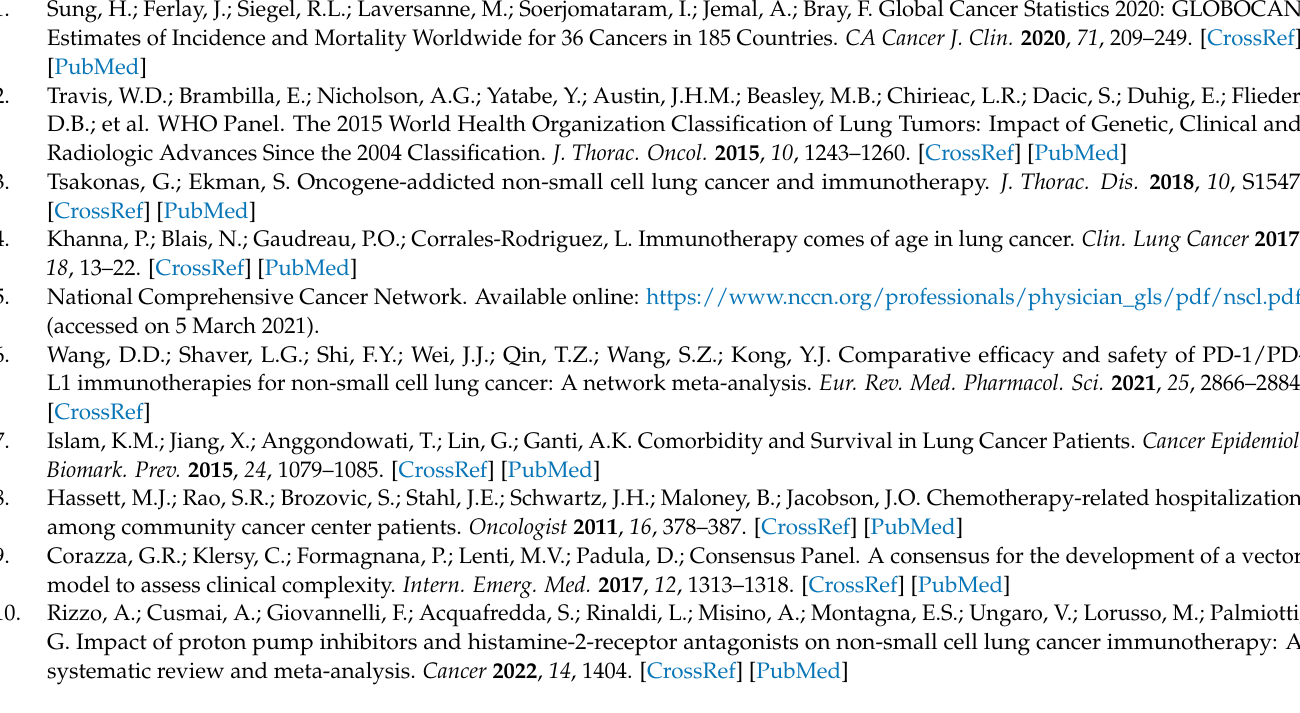
disease; Supplementary Table S4: Progression-free survival analyses. Variable = analyzed variable; Value = values that each variable assumes; HR (95% CI) = Hazard Ratio and 95% CI from Cox regression; p = p -value from Cox regression. Results reported derive from univariate analyses except for combined cohorts analysis (§), where the center ID (ICSM/PSM) was included in the model to adjust for potential differences between cohorts. * p < 0.05 # Including: soft tissue and adrenal glands; Supplementary Table S5: Points generated by the PFS and OS nomograms to each variable’s value; Supplementary Table S6: Overall survival analyses. Variable = analyzed variable; Value = values that each variable assumes; HR (95% CI) = Hazard Ratio and 95% CI from Cox regression; p = p -value from Cox regression. Results reported derive from univariate analyses except for combined cohorts analysis (§), where the center ID (ICSM/PSM) was included in the model to adjust for potential differences between cohorts. * p < 0.05 # Including: soft tissue and adrenal